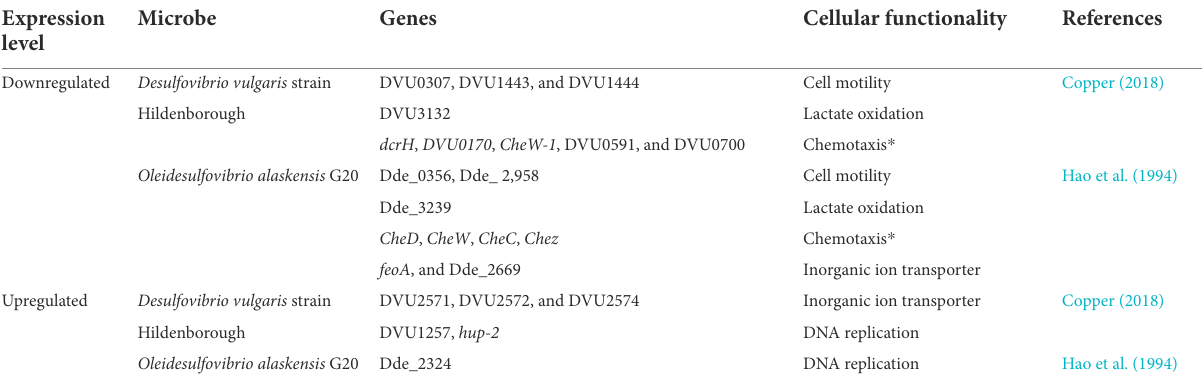
TABLE 1 Overview of gene expression profiling and adaptations displayed by sulfur reducing bacteria in response to